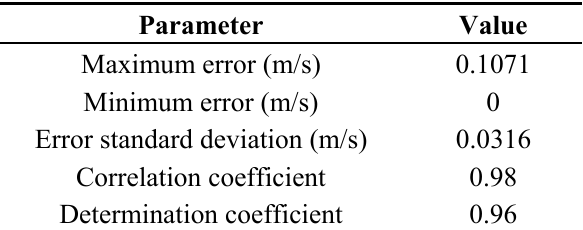
Table 3. Sampling velocity